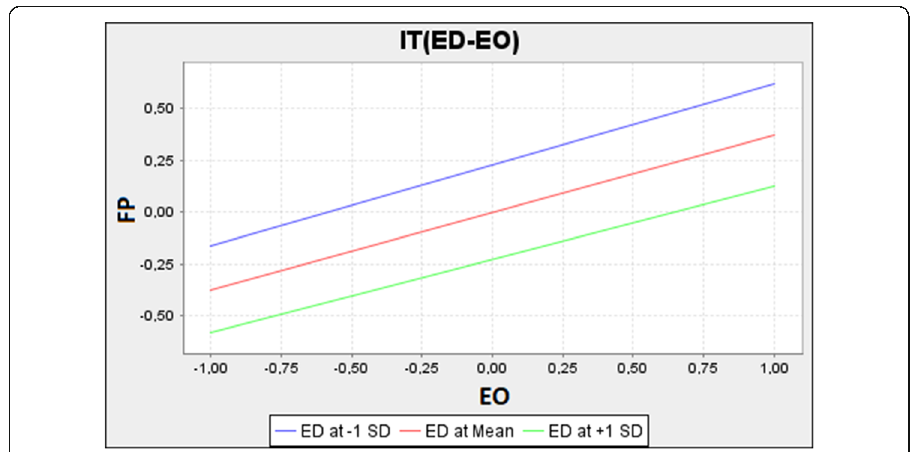
Fig. 3 Moderating effect of ED on EO and FP relationship. FP, financial performance; SD, standard deviation; IT, interaction